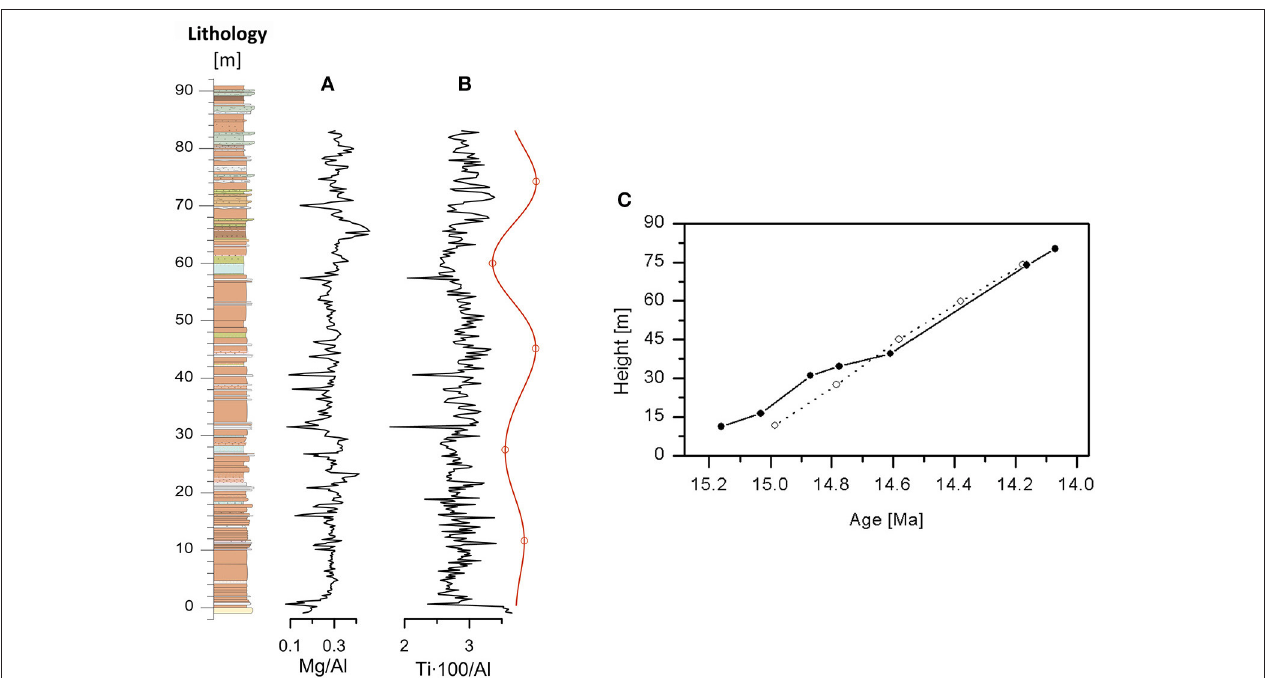
FIGURE 15 | Geochemical proxies along the profile (as in Figure 5A ): (A) Mg/Al ratio and (B) Ti/Al ratio with long eccentricity filter output in red (both from Voigt et al., 2017 ), and (C) height vs. age correlation from magnetostratigraphy (black line) and time-series analysis of the Ti/Al ratio (dotted). wet mudflat facies, likely dissolved the magnetite particles partially ( Figure 10 ), shifting the magnetic grain assemblage toward smaller magnetite grains (still larger than SP